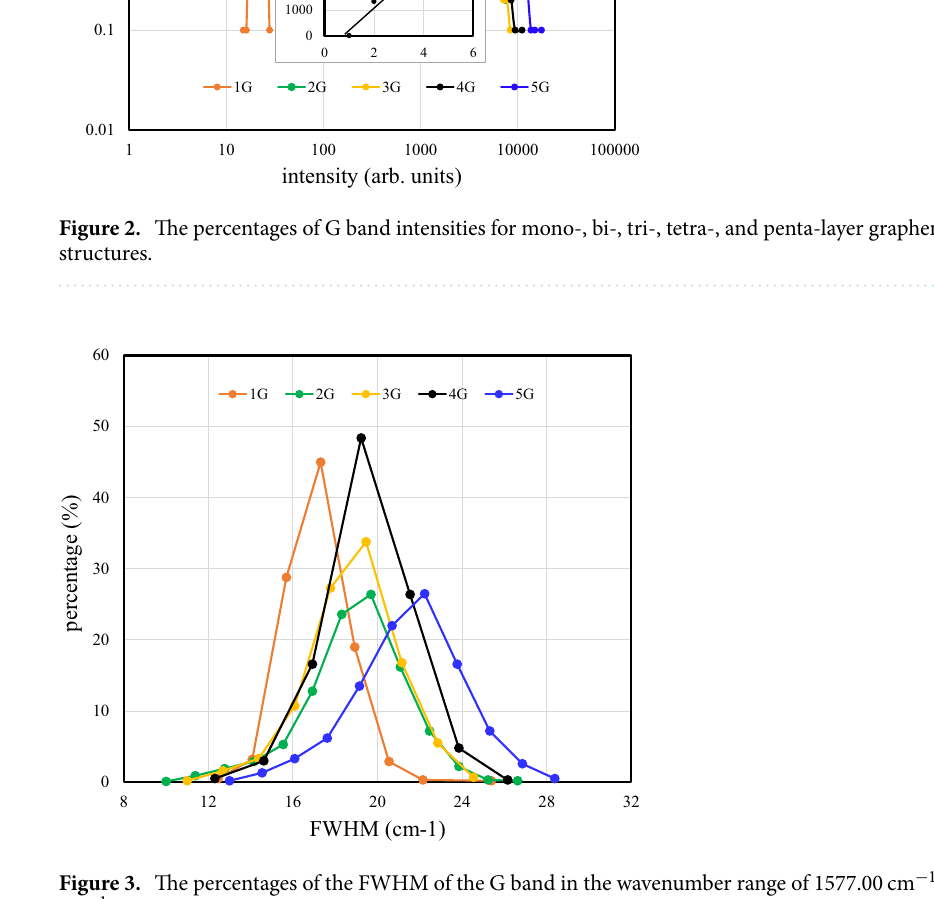
Figure 3. The percentages of the FWHM of the G band in the wavenumber range of 1577.00 cm cm − 1